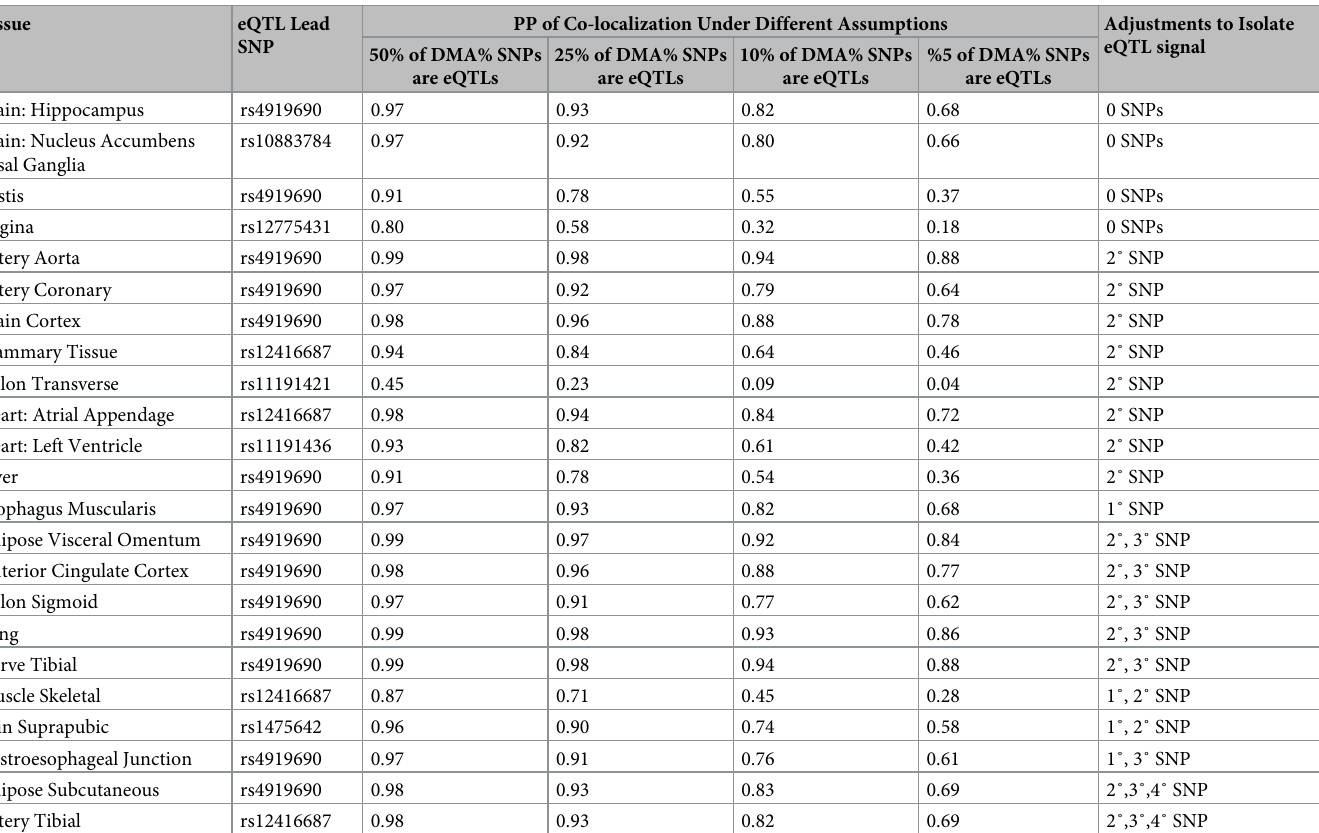
Table 5. Co-localization of AS3MT eQTLs identified in GTEx tissues with the association signal for DMA% (lead SNP rs4919687) identified in a Bangladeshi popu- lation across a range of prior probabilities.